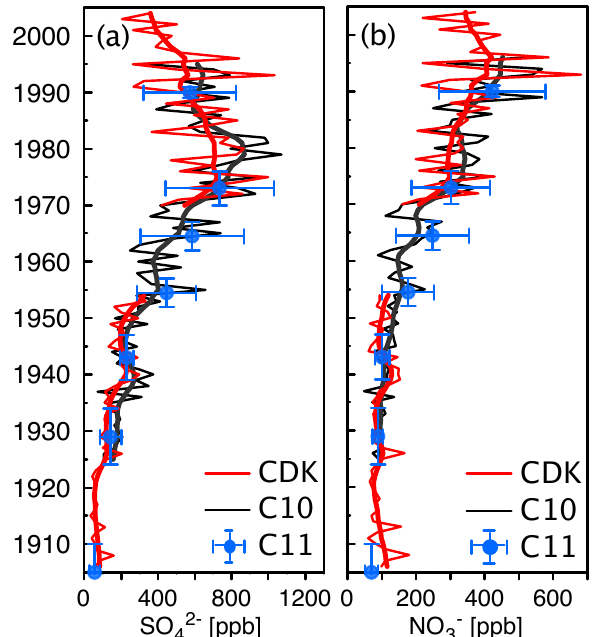
Fig. 2. Comparison of summer half-year means of sulfate and ni- trate along the C10, C11, and CDK ice cores. For C10 and CDK, the thin solid lines refer to individual summer means and the thick solid lines to the smoothed profiles (singular spectrum analyses, time window of 5yr). For C11, the discontinuous sampling (blue dots) is reported with vertical bars referring to the standard devia- tions related to sample content variability and horizontal bars to the covered time periods. C10 data are from Preunkert et al. (2001b, 2003), C11 data from Legrand et al. (2007a), and CDK data from Legrand et al. (2013). All data were corrected from the Saharan dust contribution (see Sect. 3.1). Adapted from Legrand et al. (2013).